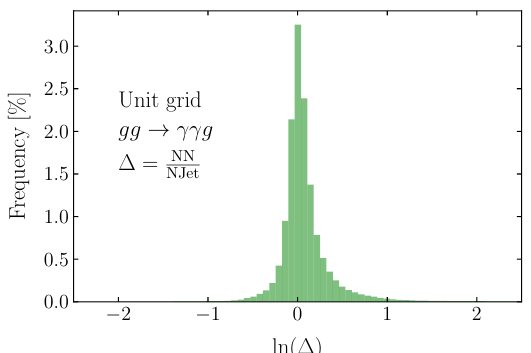
Figure 2. NN/ NJet errors for the 2 → 3 scattering process using a unit integration